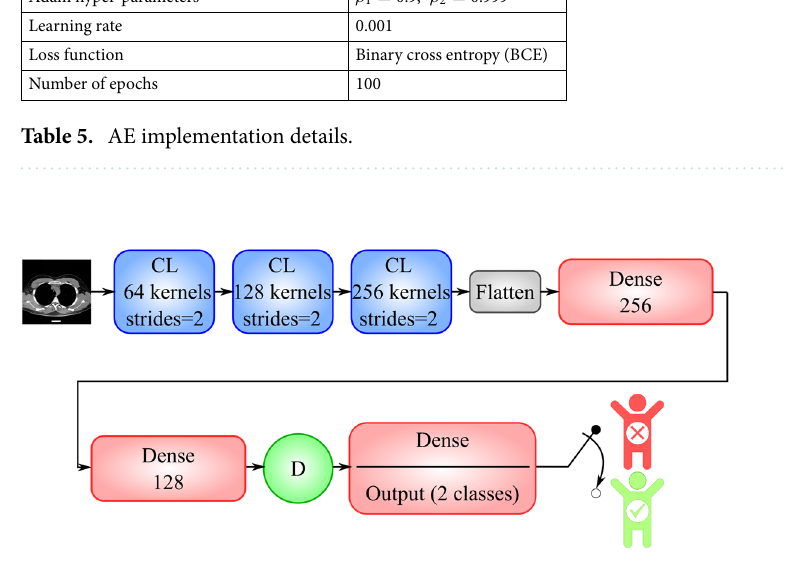
Figure 8. Implementation details of the CNN trained on CT images. ‘CL’ and ‘Dense’ represent convolutional and fully connected layers, respectively. Circles with the letter ‘D’ represent dropout layers with a probability